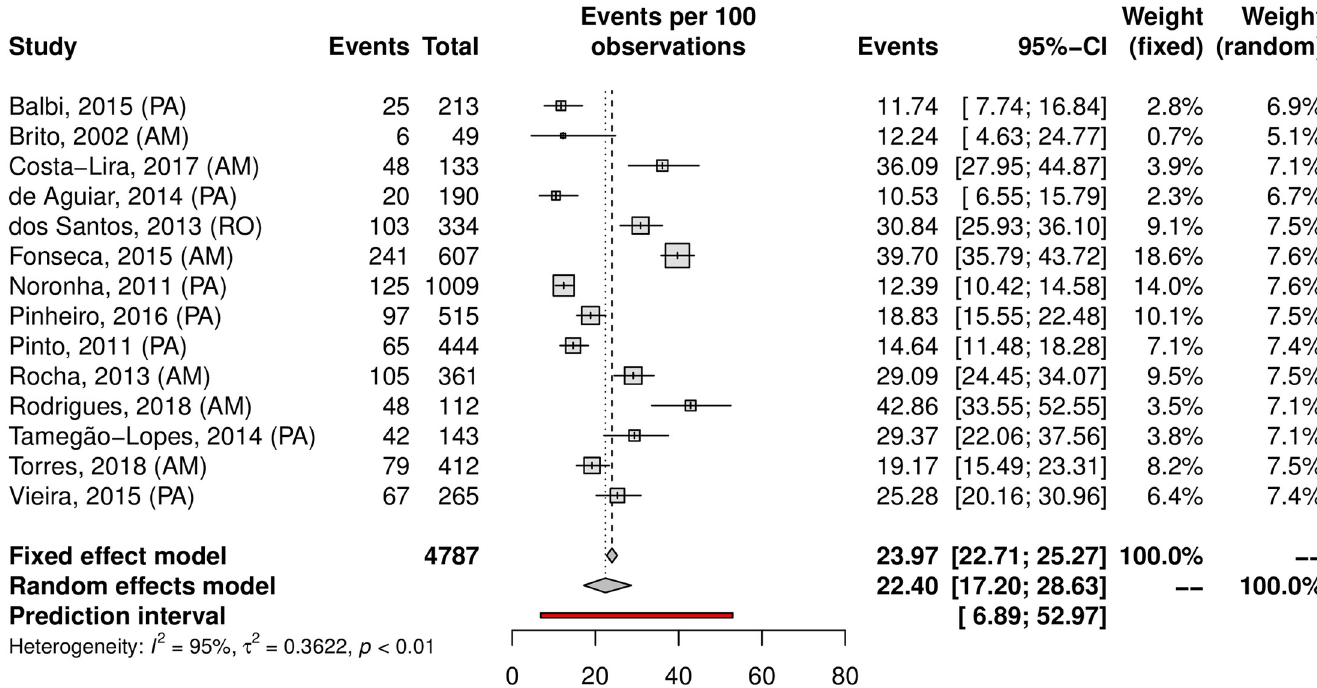
Fig 9. Prevalence of cervical HPV in the North region of Brazil. Forest plot of a metanalysis of studies reporting prevalence of cervical infection by HPV in the North region of Brazil.